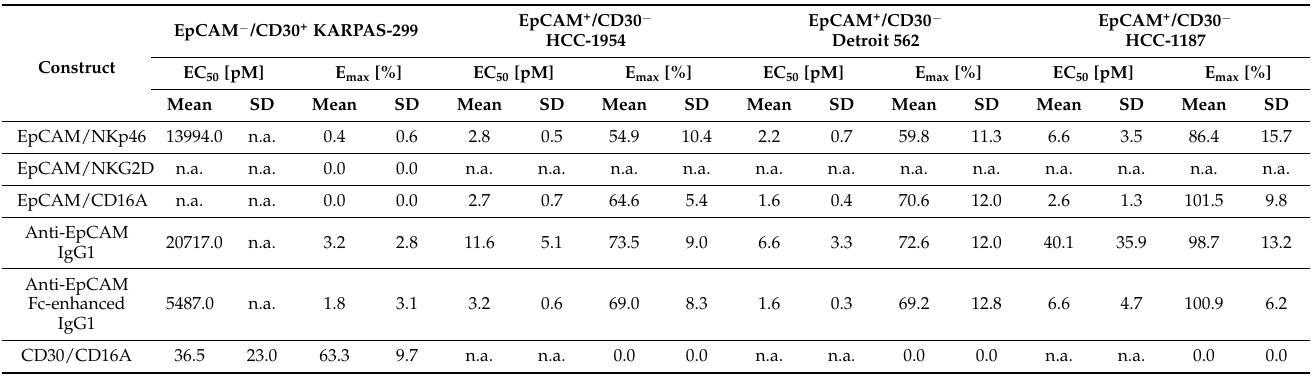
Table 7. Cytotoxicity of bispecific ICE ® constructs and control antibodies tested on target tumor cells with or without EpCAM and CD30